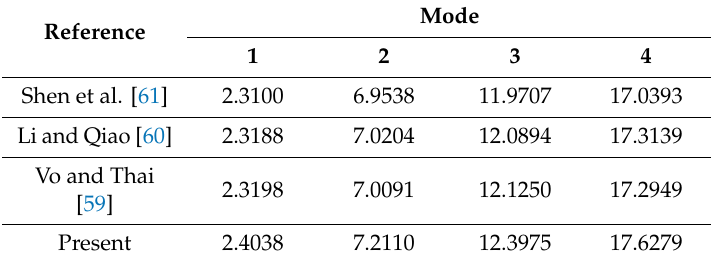
Table 3. Comparison of the first four dimensionless natural frequencies ( ω L = ω L × orthotropic thick beams based on di ff erent higher-order shear deformable beam theories ( L / h t =